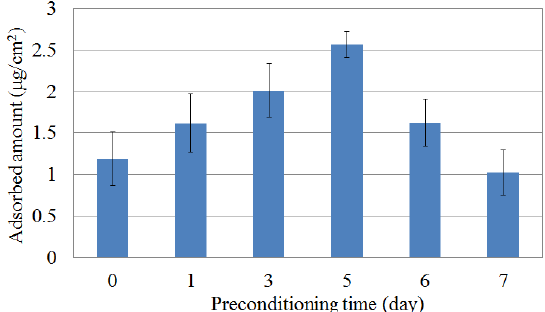
Figure 7. Relationship between the amount of adsorbed iso -alpha acid onto lipid/polymer membrane and the preconditioning time. Data are expressed as mean ± SD (n = 6).